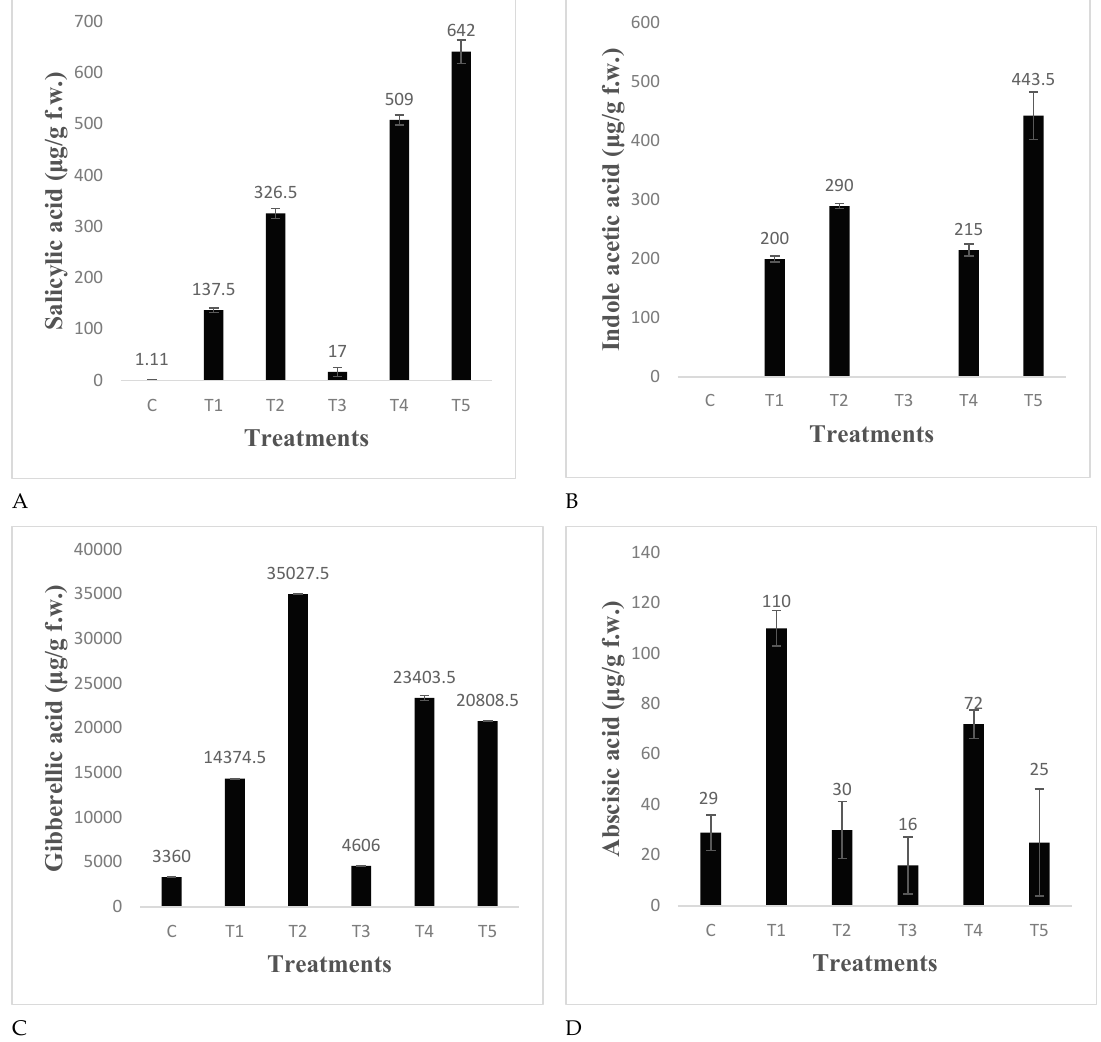
Figure 10. Phytohormone content in the leaves of tomato plants infested with S. litura and under control condition. ( A ): Salicylic acid; ( B ): Indole acetic acid; ( C ): Gibberellic acid; ( D ): Abscisic acid.